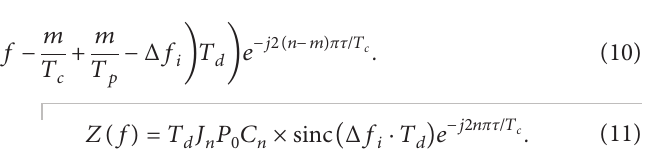
Figure 15: Sinc function envelope of pulse interference and ranging code spectrum line ( T